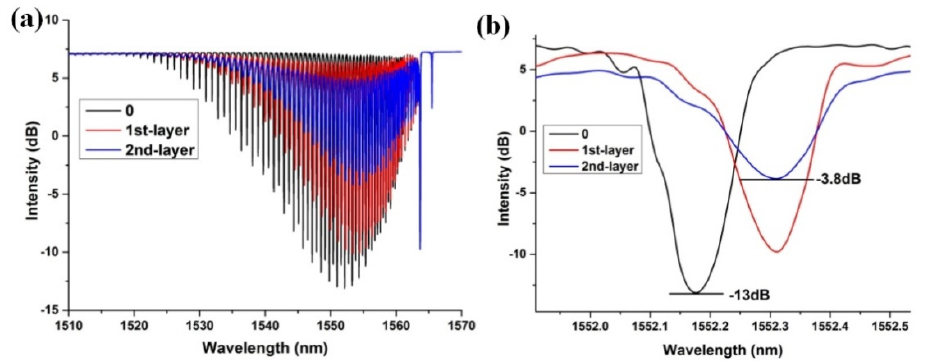
Figure 6. The transmission spectra of ( a ) whole cladding modes and ( b ) the cladding mode around 1552 nm of the black phosphorus integrated with weakly tilted fiber Bragg grating (BP-WTFBG) with